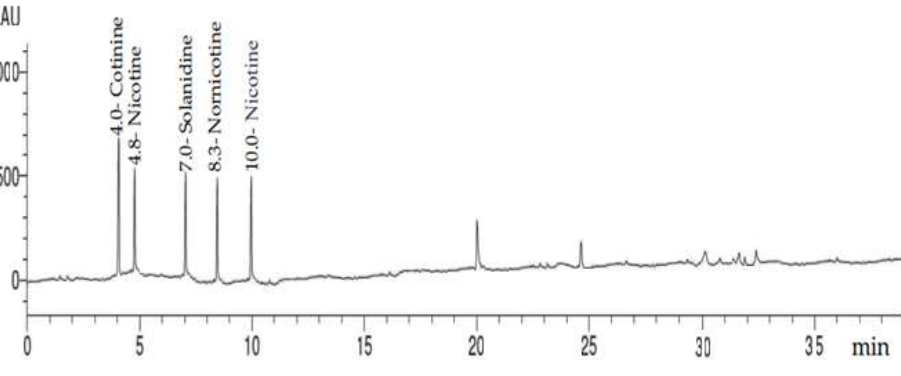
Figure 3. HPLC chromatogram of alkaloid compounds (standard mixture).